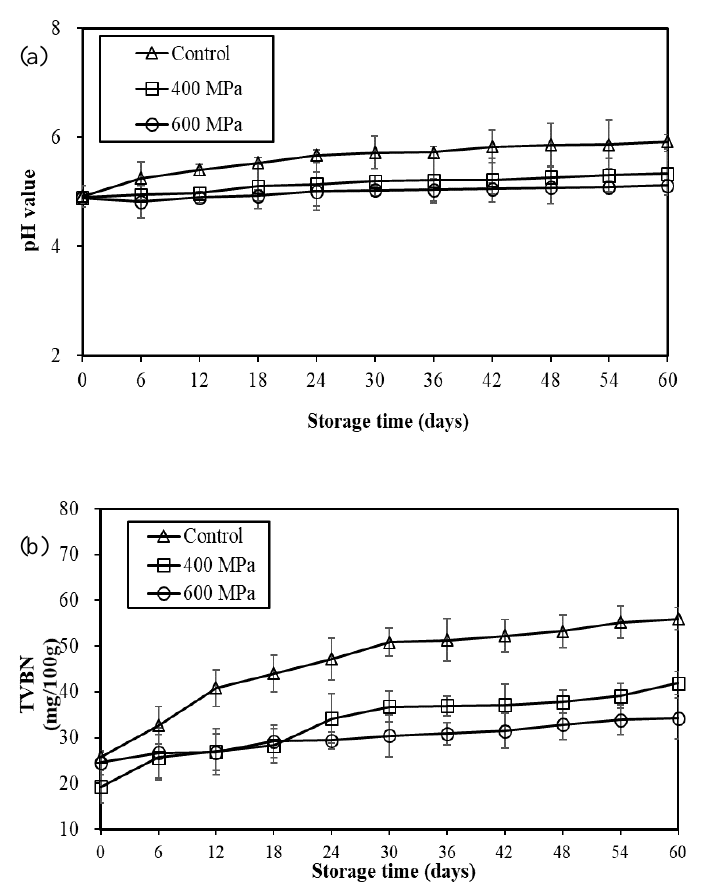
Figure 3. Changes of ( a ) pH value and ( b ) total volatile basic nitrogen (TVBN) in mustard pickles treated with HHP at 400 and 600 MPa for 5 min during storage at 25 °C.